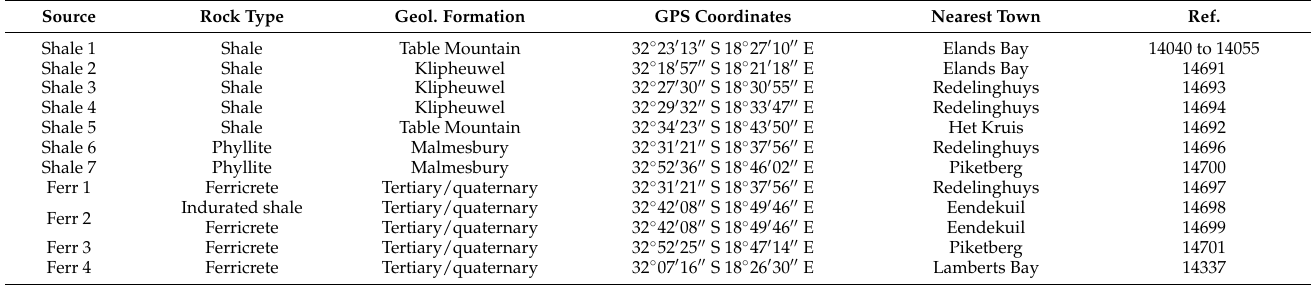
Table 4. Geological outcrops sampled for ochre raw material characterization and provenance studies at Diepkloof rock shelter. Samples from this geological collection were used to investigate the limits of non-invasive application of SEM-EDXS, XRD, and particle-induced X-ray emission (PIXE) analyses on cohesive pieces. Legend—Geol.: geological; Ref.: reference. Source Rock Type Geol. Formation